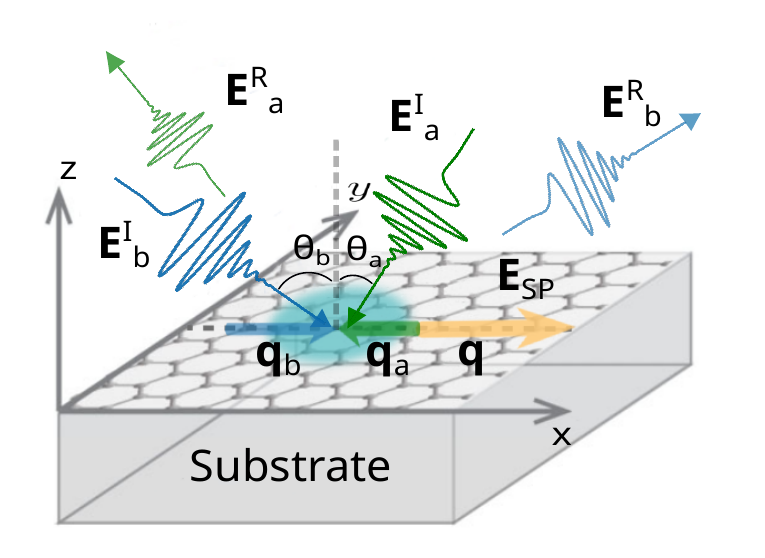
Figure 1. Schematics of all-optical generation of surface plasmons via a frequency-difference NL process of interaction of two optical beams, a and b , represented by their electric fields EEE a , b , including the incident and reflected ones. EEE SP represent the surface plasmon